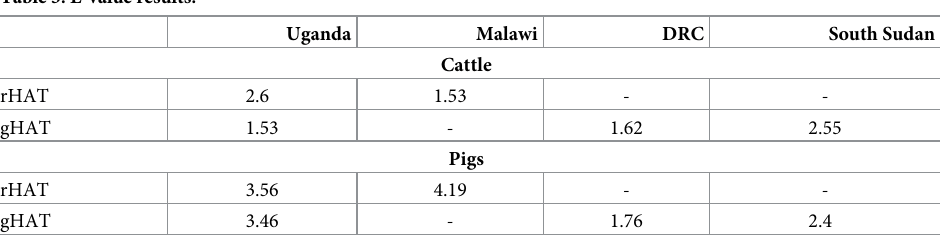
Table 5. E-value results. Uganda Malawi DRC South Sudan Cattle rHAT 2.6 1.53 - - gHAT 1.53 - 1.62 2.55 Pigs rHAT - gHAT 1.76 2.4 The strength, on the relative risk or rate ratio scale, of the relationship between an unmeasured confounder and exposure (livestock density) and between an unmeasured confounder and outcome (HAT risk) that would be required to fully explain the estimated effect. South Sudan results are presented for measurement error